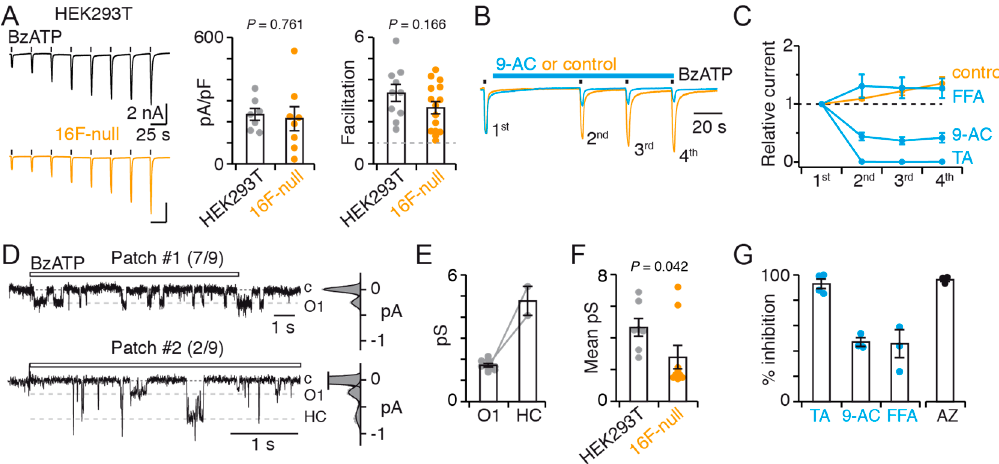
Figure 7. TMEM16F shapes P2X7 unitary conductance. ( A ) Left: whole-cell currents evoked by repeated 2 s applications of 10 μ M BzATP recorded in HEK293T (black trace) and 16F-null cells (orange trace) transiently transfected with rP2X7. Middle: summary of current density of the 8 th application ( n = 7 for HEK293T cells and 8 for 16F-null cells). Bars represent mean ± SEM. Right: summary of current facilitation determined between the 8th and 1st application. See Materials and Methods for calculation ( n = 10 cells for HEK293T and 15 for 16F-null). p values are from unpaired Student’s t -test. ( B ) Whole-cell currents evoked by repeated 2 s applications of 10 μ M BzATP in the presence (blue) or absence of 9-AC (orange) in 16F-null cells transiently expressing rP2X7. Currents are normalized to the first application. ( C ) Summary currents relative to the first application in the absence (control) or presence of inhibitors ( n = 4 cells for TA, 10 for 9-AC, 7 for FFA, and 8 for control). Symbols represent mean ± SEM. ( D ) Top (patch #1, representative of 7 out of 9 patches): single-channel currents elicited by 10 μ M BzATP from an outside-out patch of 16F-null cell transiently transfected with rP2X7 exhibiting the O1 state (dashed grey line); c, closed state. Corresponding all points histogram of currents is shown right of the trace. Distributions were fit by the sum of two Gaussians. Bottom (patch #2, representative of 2 out of 9 patches): example of outside-out patches in which O1 and an additional high conductance (HC) were recorded (dashed grey lines). Currents were elicited by 10 μ M BzATP. Corresponding all points histogram of currents is shown right of the trace. Distributions were fit by the sum of three Gaussians. Data were filtered at a final f c of 100 Hz. ( E ) Summary of corresponding unitary conductances in 16F-null cells. Linking lines indicate data points that originate from the same patches ( n = 9 patches). Bars represent mean ± SEM. ( F ) Summary of mean P2X7 unitary conductances in HEK293T and 16F-null cells. Mean was calculated by averaging the sum of each state conductance determined from each patch ( n = 7 patches for HEK293T cells and 9 for 16-null cells). Bars represent mean ± SEM. p value is from Mann-Whitney test. ( G ) Summary of single-channel inhibition ( n = 4 patches for TA, 3 for 9-AC, 3 for FFA, and 3 for AZ10606120). Bars represent mean ± SEM. Inhibitor concentrations were 20 μ M TA, 1 mM 9-AC, 100 μ M FFA and 1 μ M AZ10606120. Single-channel and whole-cell data were recorded at -120 and -60 mV, respectively.